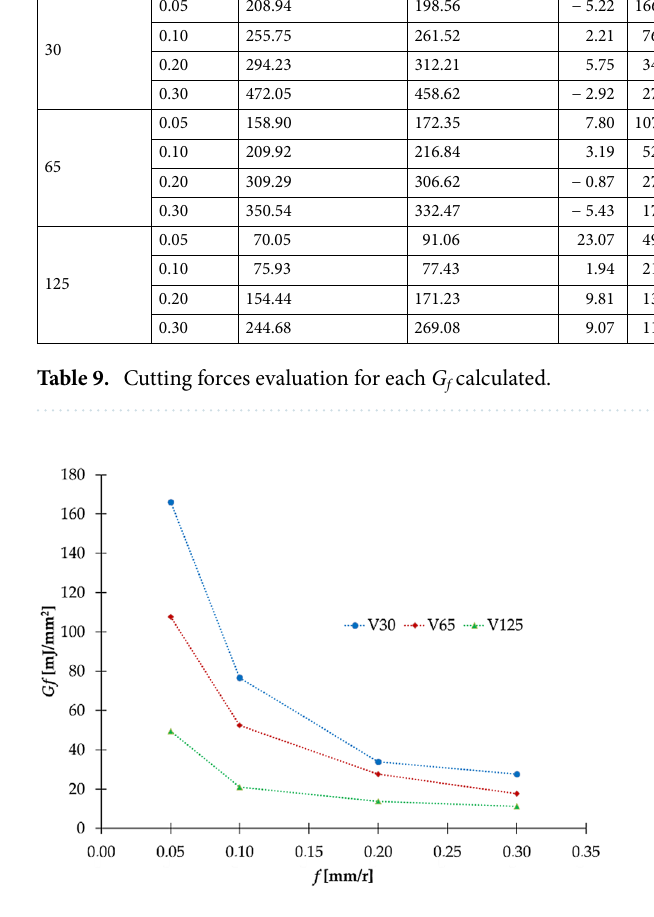
Figure 4. Evolution of the fracture energy as a function of f and